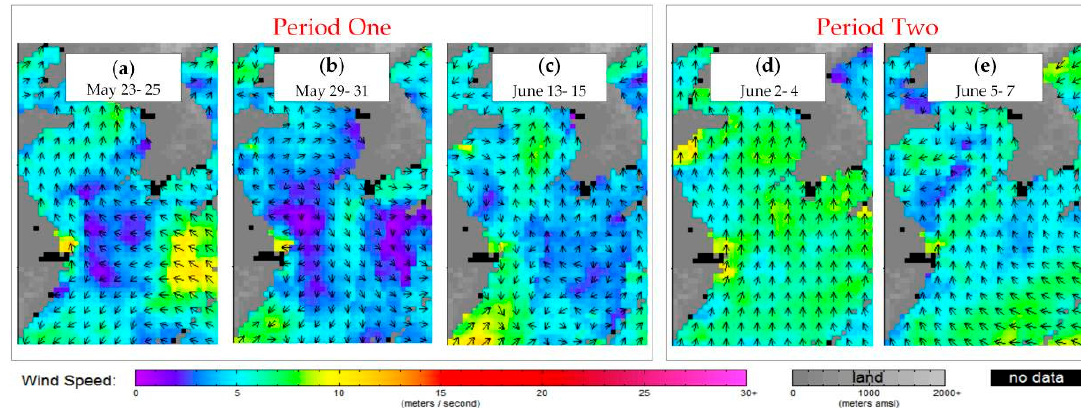
Figure 18. Three-day average surface wind speed and direction of oblateness change periods in 2016, obtained from RSS. ( a – c ) The change of SSW in period one. ( d , e ) The change of SSW in period two.